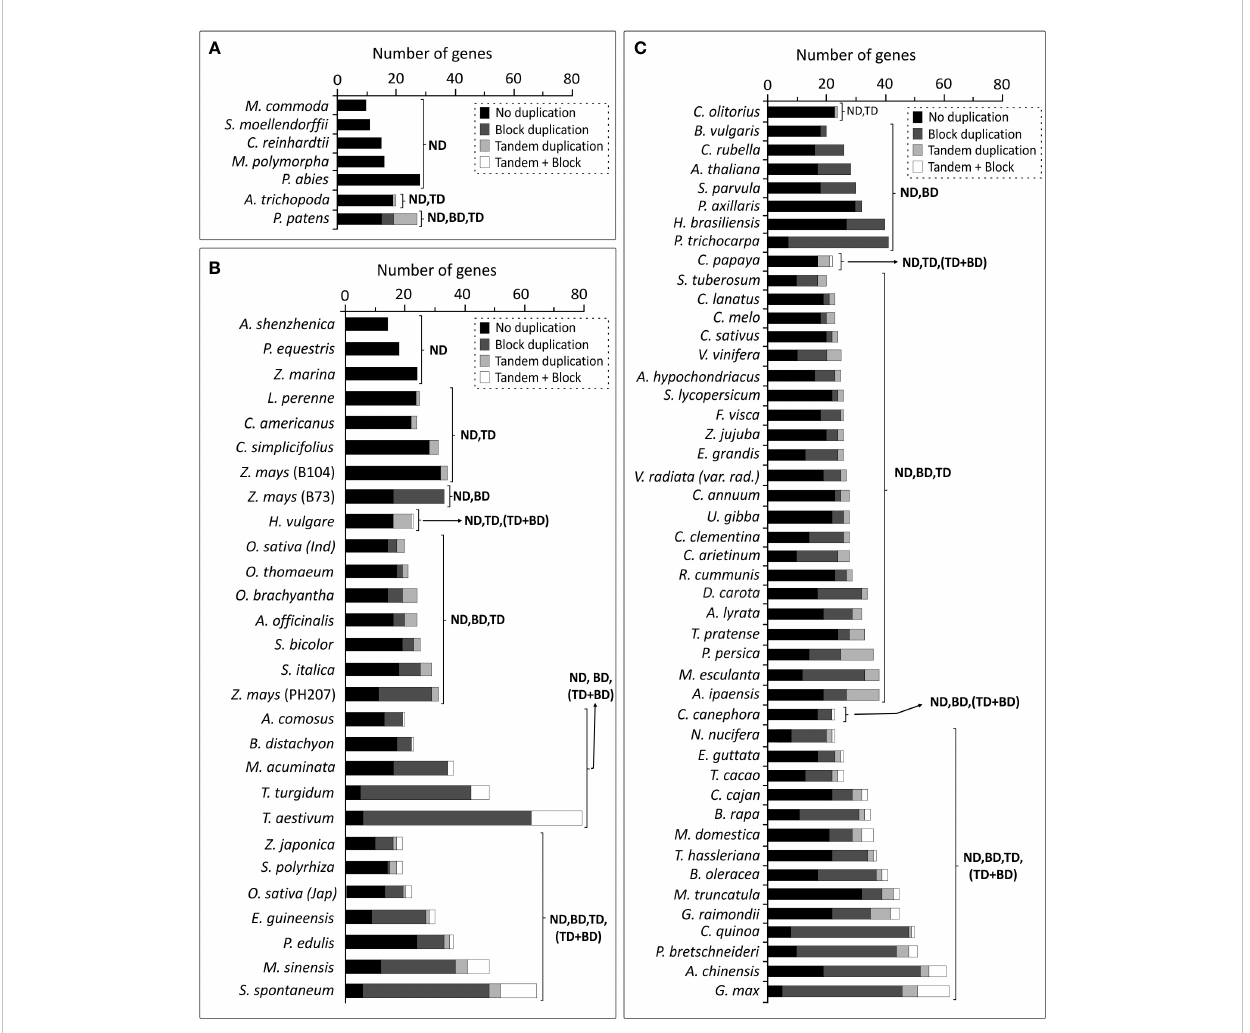
FIGURE 11 Comparative assessment of duplication events affecting Brd -gene copies among different plant genomes: (A) lower photosynthetic organisms, (B) monocots, and (C) dicots, as per analysis at PLAZA database (version 4.5). Types of duplication events are indicated by different grey shades and designations ND (no duplication), TD (tandem duplication), BD (block duplication), and TD + BD (combined tandem and block